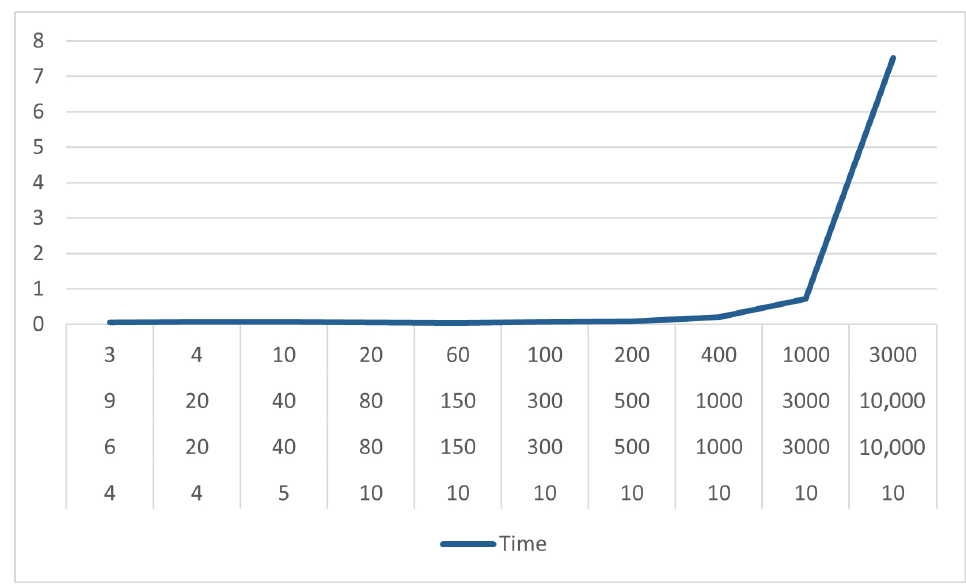
Figure 4. Time variation over the number of terminals, drivers, slots and access